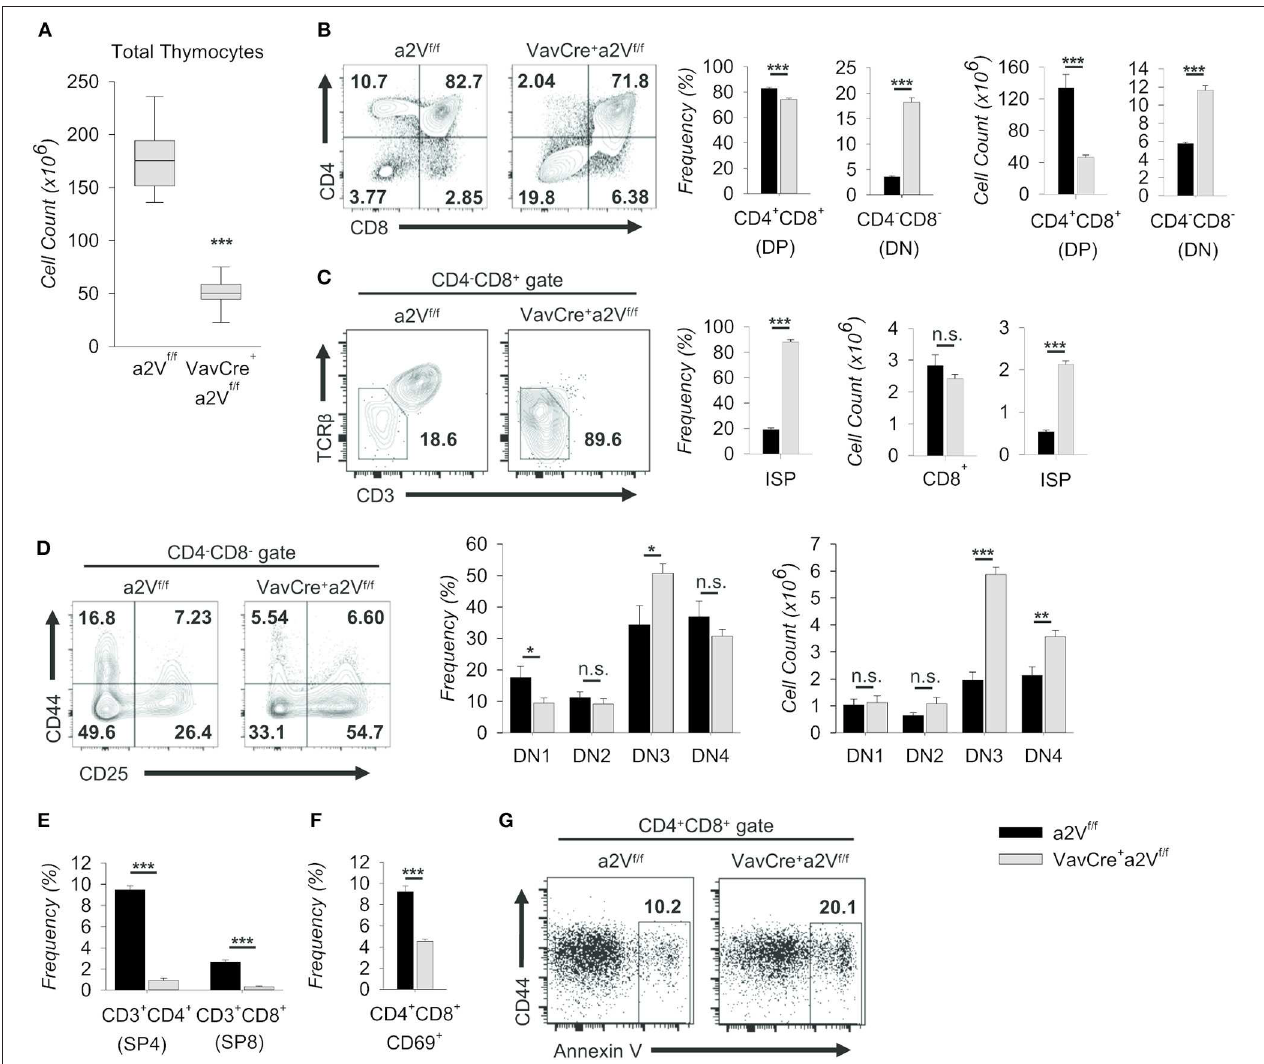
FIGURE 5 | Characterization of intrathymic development in Vav Cre a2V fl / fl mice. Thymocytes from a2V fl / fl and Vav Cre a2V fl / fl mice were isolated, counted by Trypan blue exclusion on a hemocytometer or by size exclusion on a BD Accuri C6, and analyzed by flow cytometry (A–G) . (A) Absolute number of thymocytes isolated from a2V fl / fl and Vav Cre a2V fl / fl thymuses ( n = 9 each group). Data are pooled from three independent experiments and representative of 10 total experiments. (B) Flow cytometry and quantification of total thymocytes on the basis of CD4 and CD8 expression. (C) Flow cytometry and quantification of CD8 + CD3 − / lo TCR β − / lo (ISP) cells within the CD4 − CD8 + gate. (D) Representative flow plots and quantification of DN subpopulations based on the surface expression of CD44 and CD25 (DN1, CD44 + CD25 − ; DN2, CD44 + CD25 + ; DN3, CD44 − CD25 + ; DN4, CD44 − CD25 − ). (E) Frequency of post-selection SP thymocytes. (F) Frequency of CD69 + DP thymocytes, representative of DP thymocytes that have begun positive selection. (G) Representative flow cytometric analysis of DP gated Annexin V + thymocytes. Numbers in flow plots represent the frequency of each gate or quadrant. Numeric data represents means ± SEM. Data are pooled from 3 independent experiments ( B–D , n = 6 each group) or are presented as a single independent experiment ( n = 5 (Vav Cre a2V fl / fl ) and n = 4 (a2V fl / fl )) and representative of at least 3 independent experiments. n.s., no significance, * p ≤ 0.05, ** p ≤ 0.01, *** p ≤